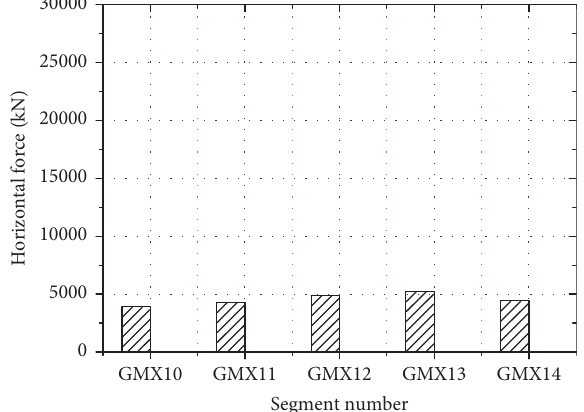
Figure 5: Horizontal force borne by each